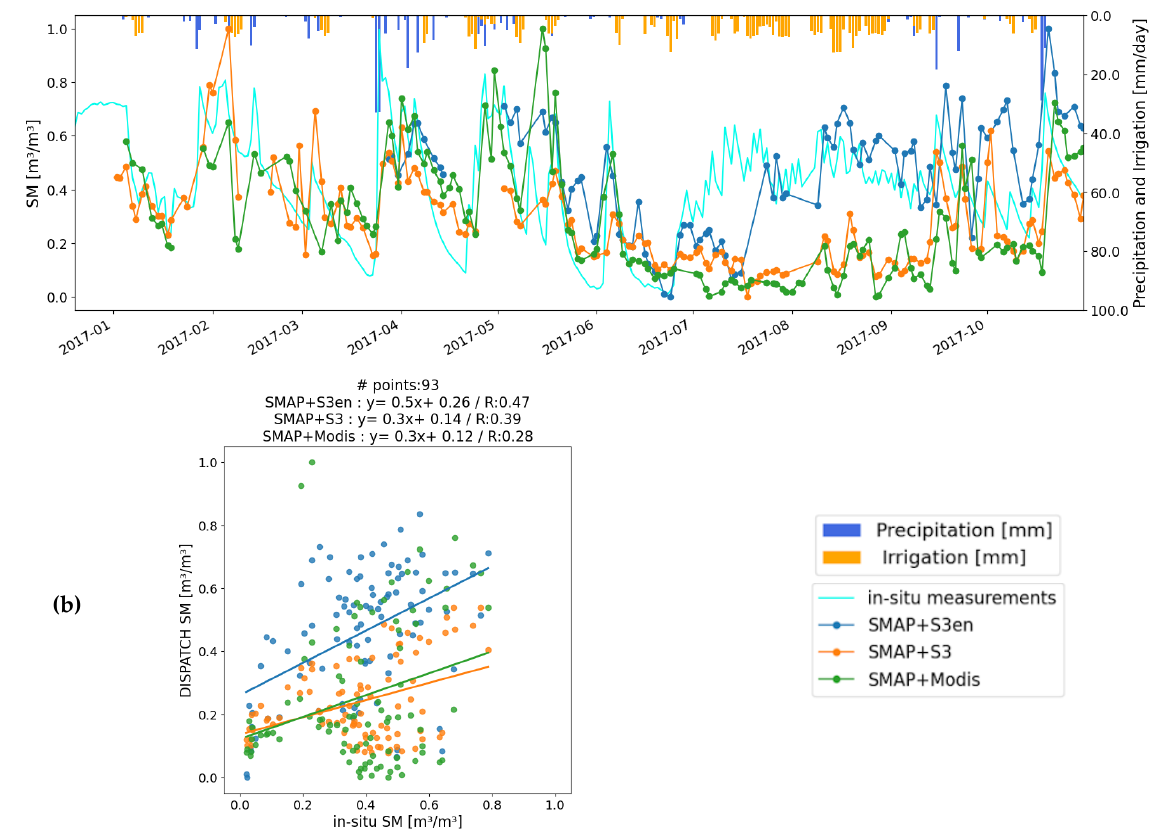
Figure 3. Time series ( a ) of in situ SSM (cyan) compared with the DisPATCh products: SMAP+MODIS (green), SMAP + S3 (orange) and SMAP + S3en (blue). The time series correspond to the data extracted in 2017 for the Foradada field, normalized to be comparable among each other. Scatter plot ( b ) of in situ data compared with the three DisPATCh products and their respective regression lines (same colors used). The text above the figure shows the number of points considered, the regression line formula and the Pearson's correlation coefficient (R). The number of points considered is equivalent for each product, since only the dates for which all the products are available are considered.